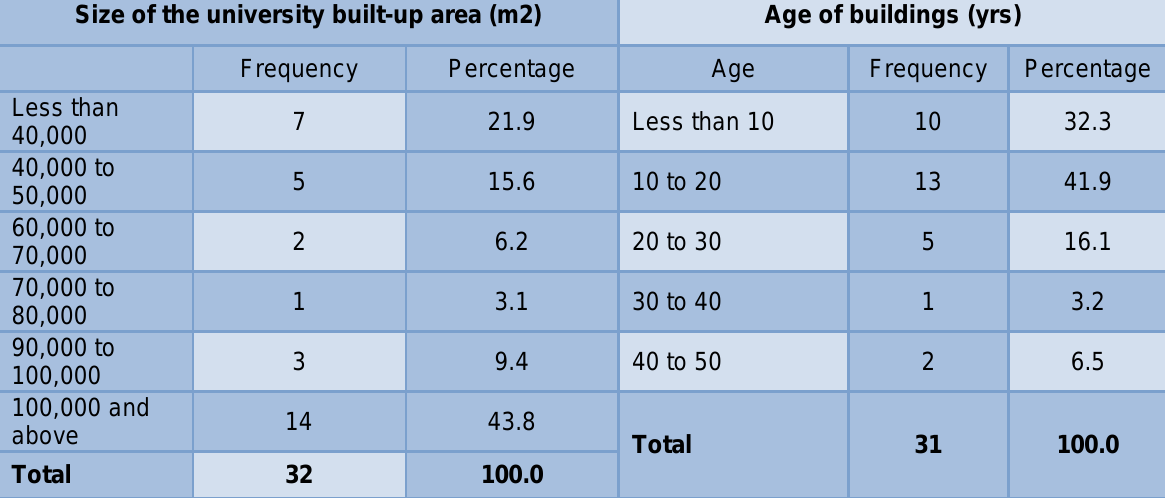
Table 2 University built-up area and average age of buildings